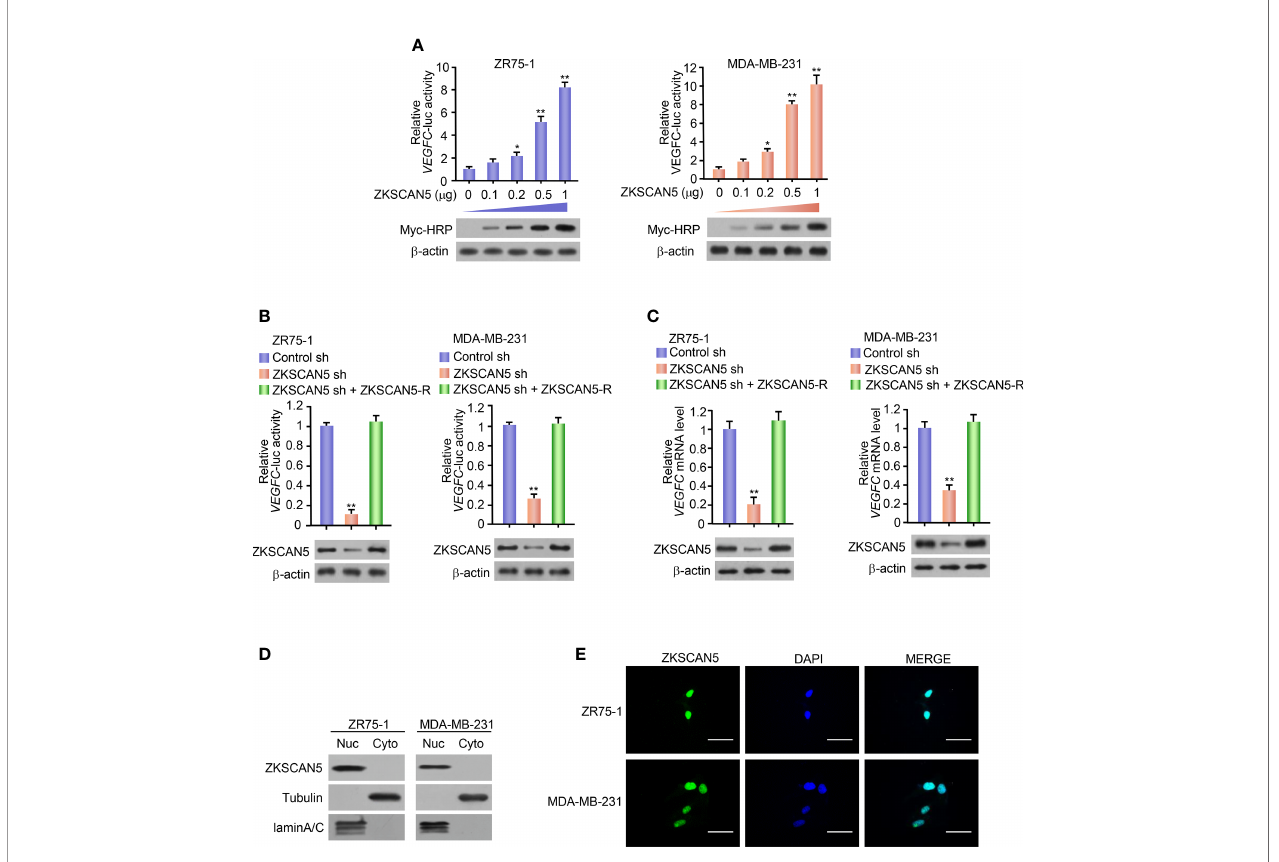
FIGURE 1 | ZKSCAN5 regulates the expression of VEGFC in breast cancer cells. (A) Luciferase reporter genes were determined in ZR75-1 and MDA-MB-231 breast cancer cells co-transfected with different concentrations of VEGFC reporter and myc-ZKSCAN5. A representative immunoblot showed the expression of myc- HRP. b -Actin was used as a control for loading. All values shown are expressed as the average value ± SD obtained from three independent experiments. *p < 0.05, **p < 0.01, and empty vector. (B) Luciferase reporter gene detection in ZR75-1 and MDA-MB-231 breast cancer cells co-transfected with VEGFC -Luc and ZKSCAN5 shRNA, VEGFC -Luc and control shRNA, or VEGFC -Luc and ZKSCAN5 shRNA plus shRNA-resistant ZKSCAN5 (ZKSCAN5-R). The representative Western blot shows ZKSCAN5 expression. Among them, b -actin was used as the loading control. (C) Real-time RT-PCR was used to analyse the VEGFC expression in ZR75-1 and MDA-MB-231 cells, which were transfected with ZKSCAN5 shRNA, control shRNA, or ZKSCAN5 shRNA plus shRNA-resistant ZKSCAN5 (ZKSCAN5-R). The representative Western blot further showed the expression of ZKSCAN5. Data shown are the mean ± SD of triplicate measurements from experiments that have been repeated three times with similar results (B, C) . **p < 0.01 versus control shRNA. (D) Cytoplasmic and nuclear ZKSCAN5 protein levels in two types of breast cancer cell lines, ZR75-1 and MDA-MB-231. Tubulin was used as the cytoplasmic control, and lamin A/C was used as the nuclear protein- loading control. (E) Immuno fl uorescence images of ZKSCAN5 cellular localisation in green, and nuclei stained in blue